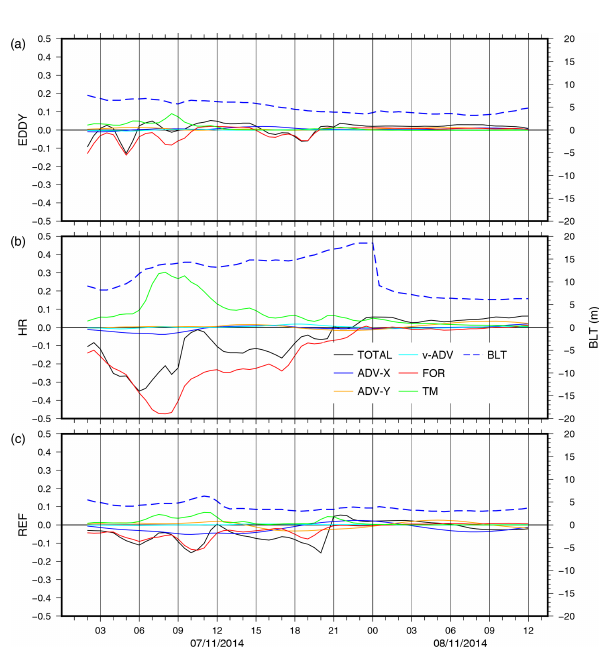
Figure 14. Time series of the different components of the tendency in the evolution of salinity in the OML, in the EDDY (a) , HR (b) , and reference (c) areas. The barrier layer thickness (BLT) is also shown (dashed blue line, right-hand-side